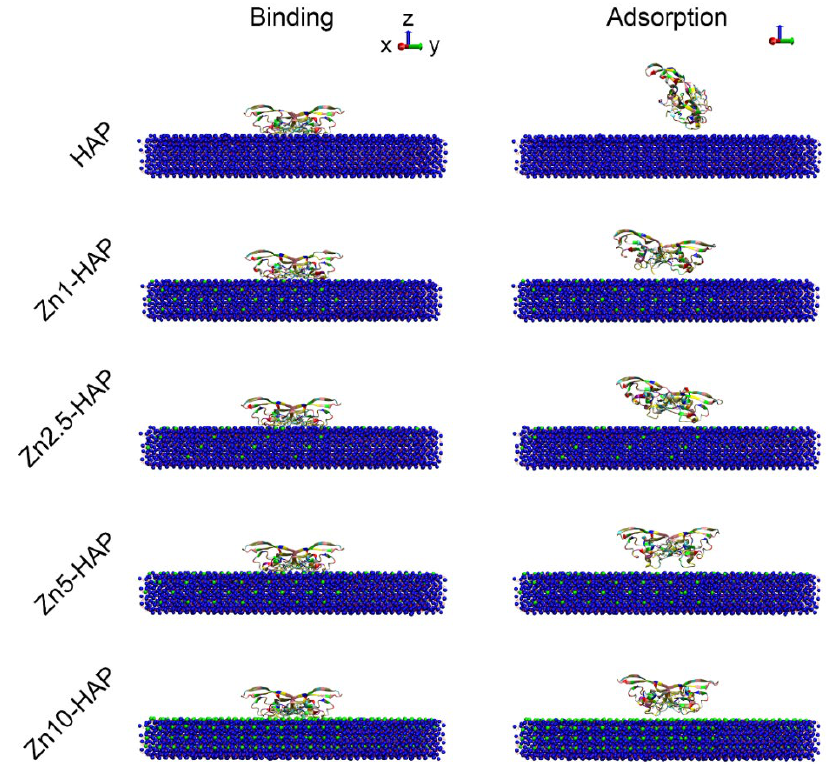
Figure 2. Snapshots of BMP-2 upon HAP and Zn-HAPs at the binding state and adsorption